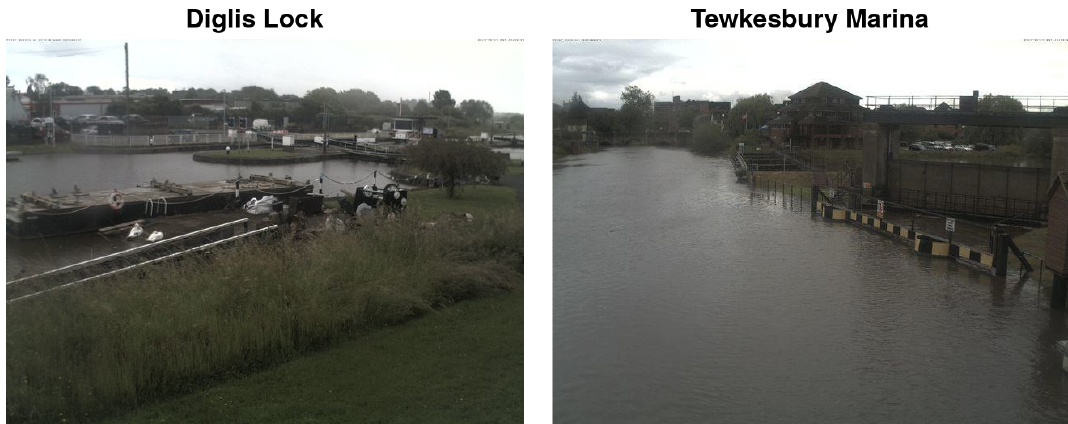
Figure 7. Fields of view from Diglis Lock and Tewkesbury Marina cameras for the period 2019–2020.